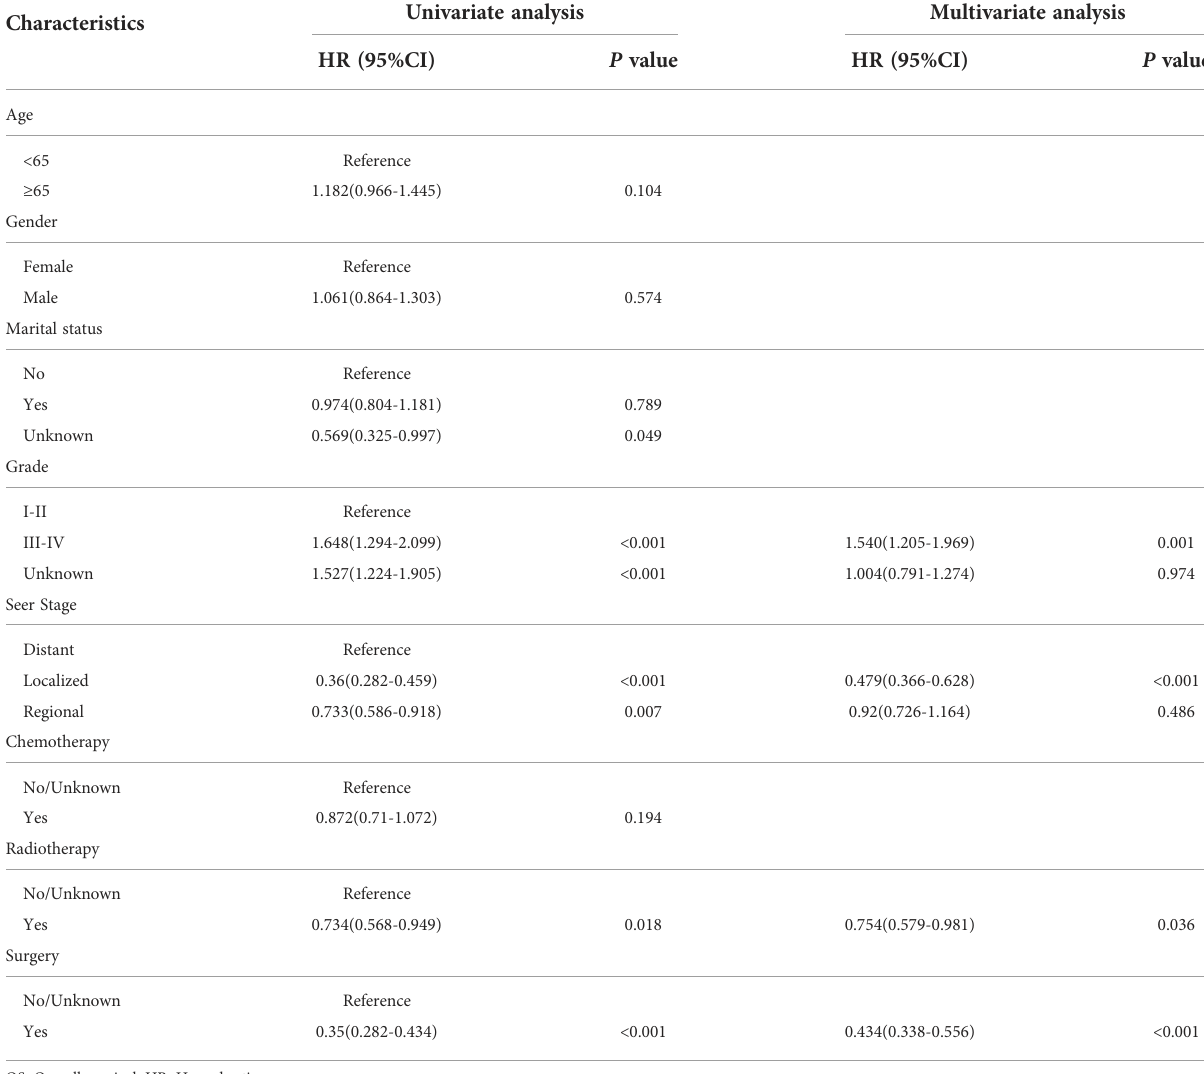
TABLE 2 Univariate and multivariate Cox regression analysis of OS in training cohort.